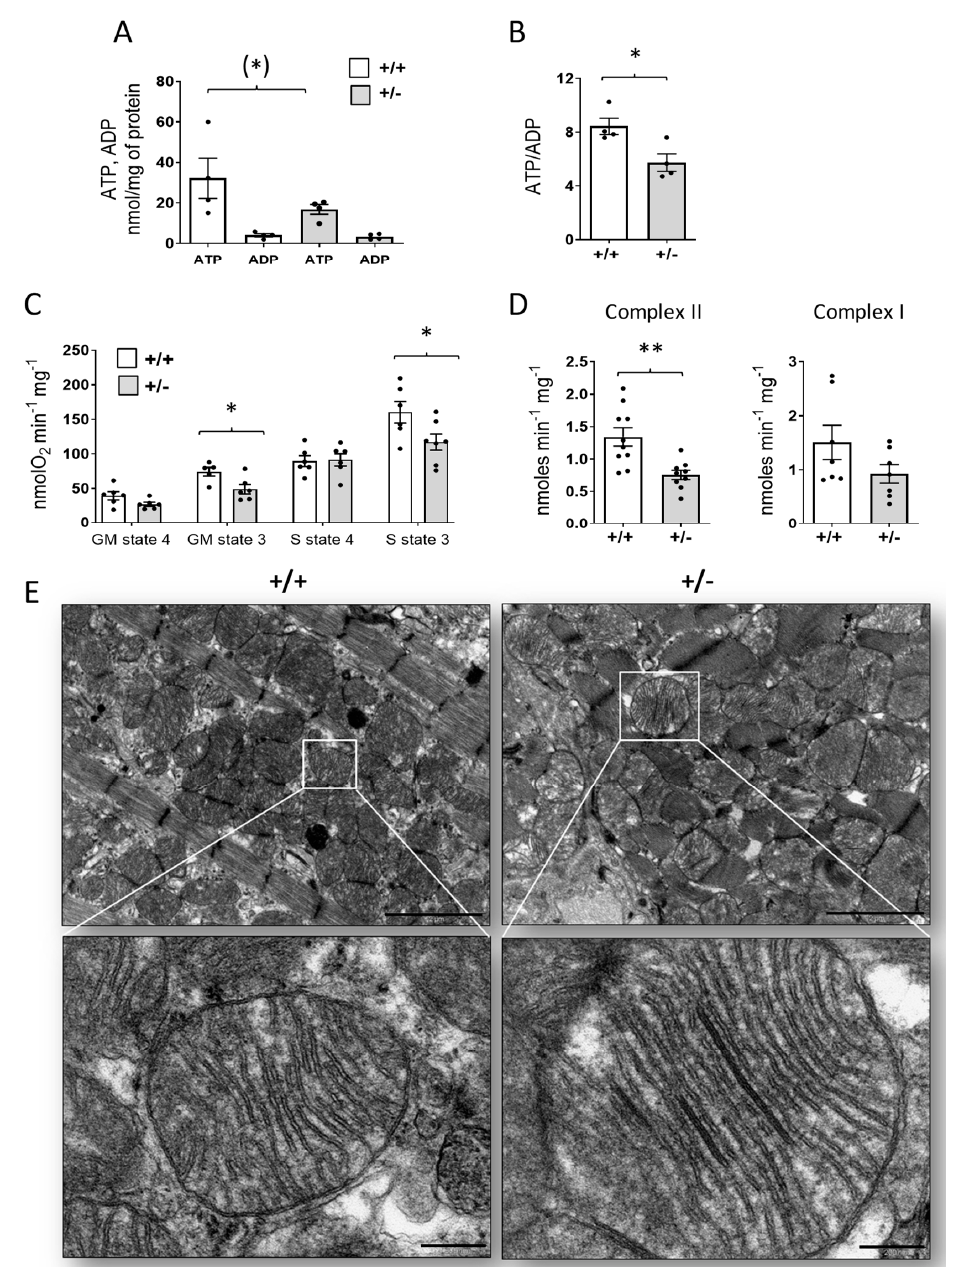
Figure 5. Mitochondrial activity in the hearts of Cdkl5 +/ − mice . ( A , B ) ATP and ADP content ( A ) and ATP/ADP ratio ( B ) in heart homogenates from Cdkl5 +/+ and Cdkl5 +/ − mice measured by HPLC (n = 4). ( C ) Oxygen consumption rate (OCR) in isolated cardiac mitochondria from Cdkl5 +/+ and Cdkl5 +/ − mice. The mitochondria were energized with glutamate–malate (GM) or succinate (S) in the presence (state 3) and absence (state 4) of ADP (n = 6). ( D ) Specific complex I (NADH-CoQ 1 ) and complex II (succinate-DCPIP) activities in isolated cardiac mitochondria from Cdkl5 +/+ and Cdkl5 +/ − mice (n = 10). ( E ) Representative electron microscopic images of ventricular tissue from Cdkl5 +/+ (left panel) and Cdkl5 +/ − (right panel) mice. In the Cdkl5 +/ − heart, linear densities are evident inside the intracristal matrix of mitochondria, while a normal cristae structure is observed in Cdkl5 +/+ mitochondria. The white boxes highlight the regions shown in the high-magnification panels. Scale bars: low magnifications = 2 µ m, high magnifications = 200 nm. The results in ( A – D ) are presented as means ± SEM; in ( A ), ( * ) p = 0.055 (Fisher’s LSD test after two-way ANOVA); in ( B – D ), * p < 0.05, ** p < 0.01 (two-tailed Student’s t